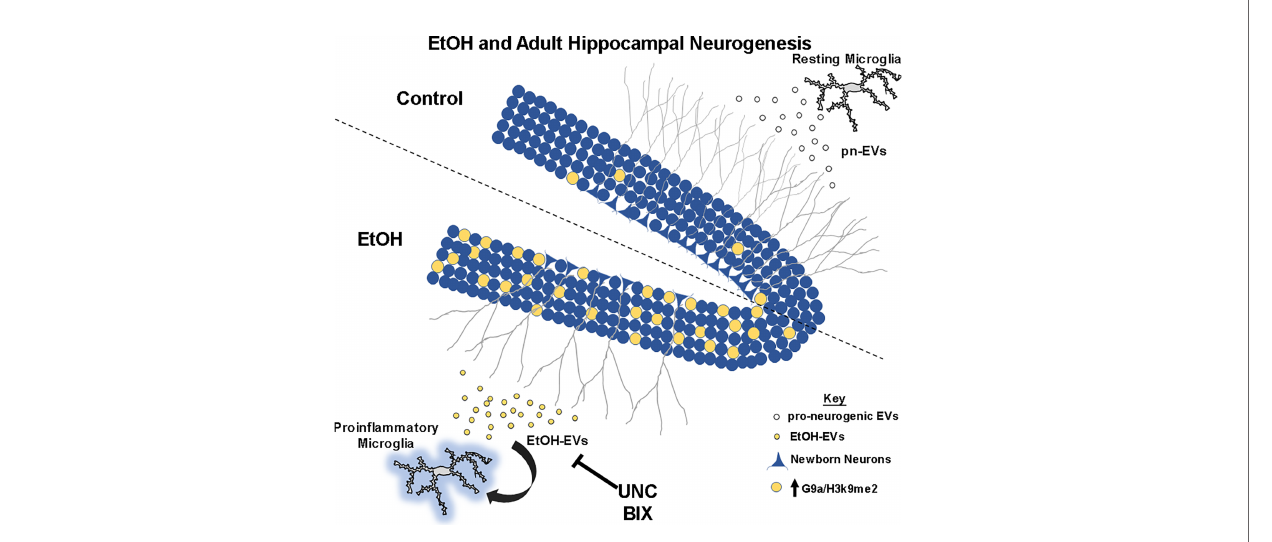
FIGURE 7 | Summary of fi ndings. At rest, microglia secrete pro-neurogenic EVs (pn-EVs) to promote neurogenesis (gray branches). Ethanol causes proin fl ammatory activation of microglia, with secretion of proin fl ammatory EtOH-EVs (Crews et al., 2021) now found to be enriched with G9a mRNA. EtOH induces G9a and H3K9me2 (yellow) in the neurogenic niche of the dentate gyrus to blunt neurogenesis (gray branches). Inhibition of G9a activity with UNC and BIX prevent loss of neurogenesis caused by EtOH and